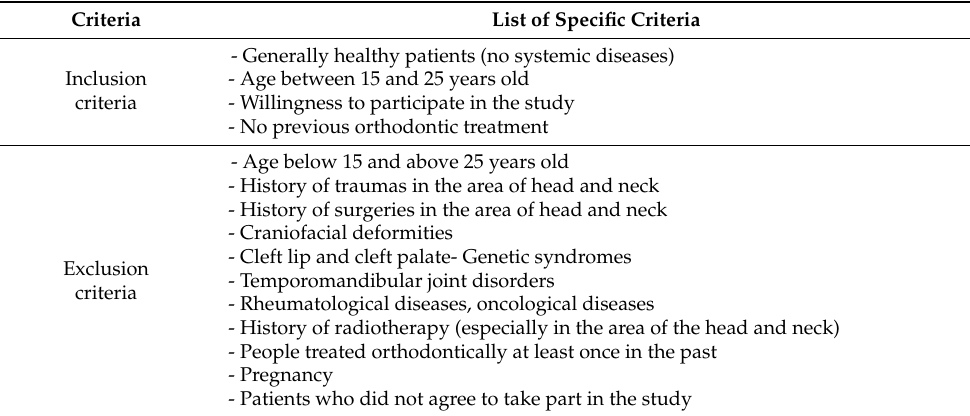
Table 1. Inclusion and exclusion criteria for the examined